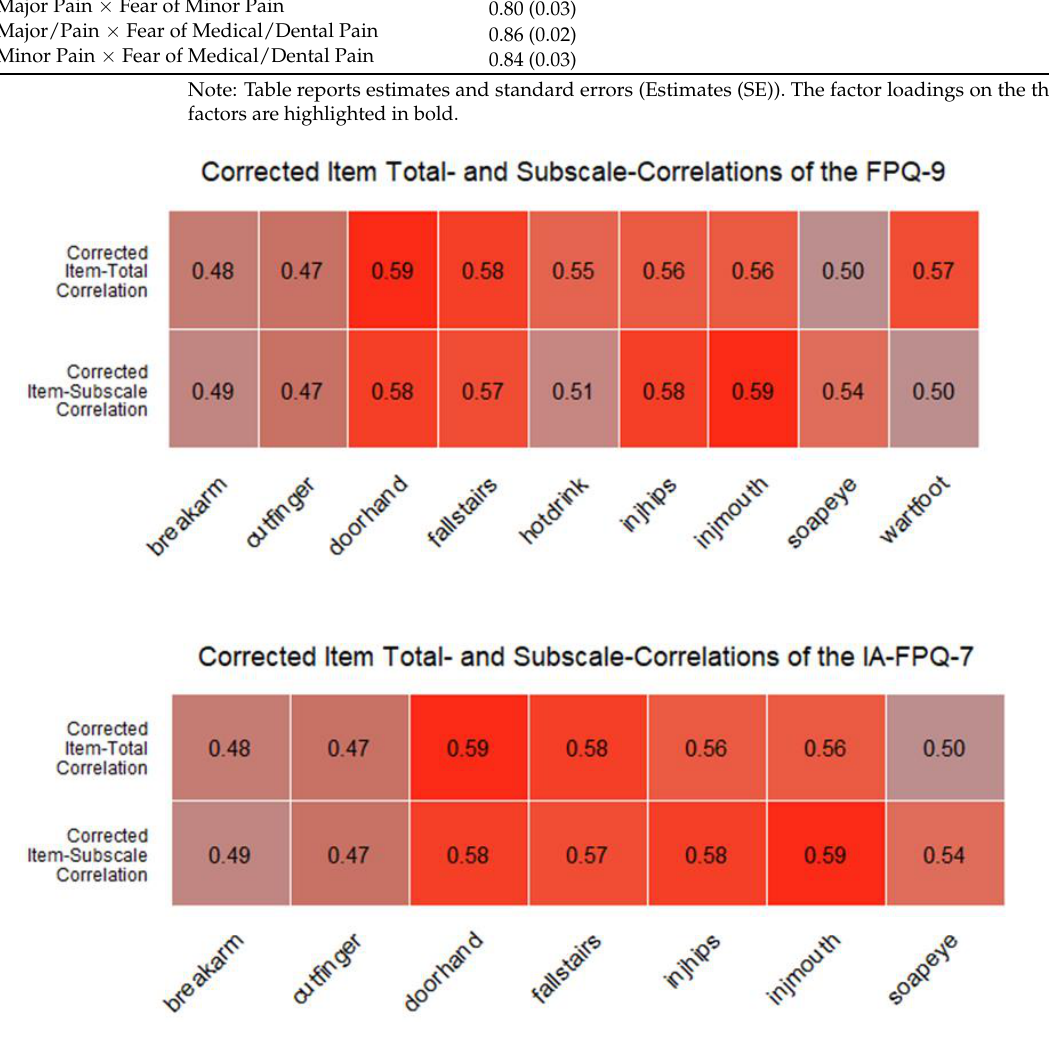
Table 3. Factor model of three-factor IA-FPQ-7 in Indigenous Australian.